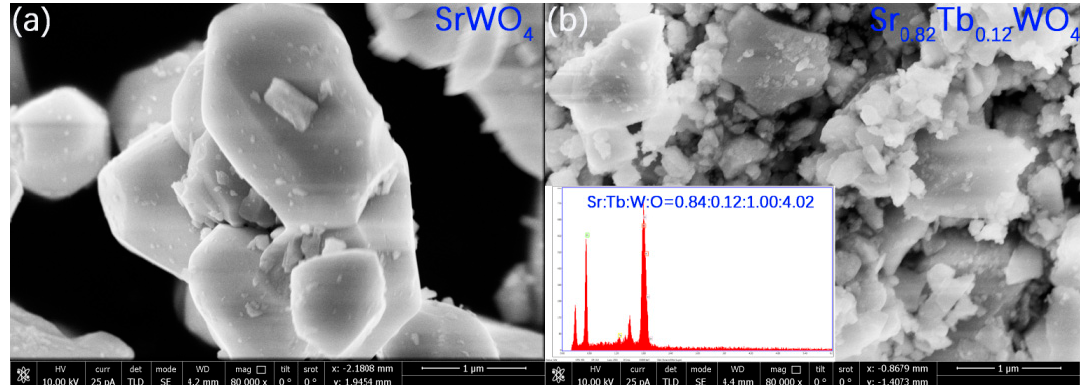
Figure 3. ( a ) SEM image for SrWO 4 . ( b ) SEM and EDS image for Sr 0.82 Tb 0.12 WO 4 .